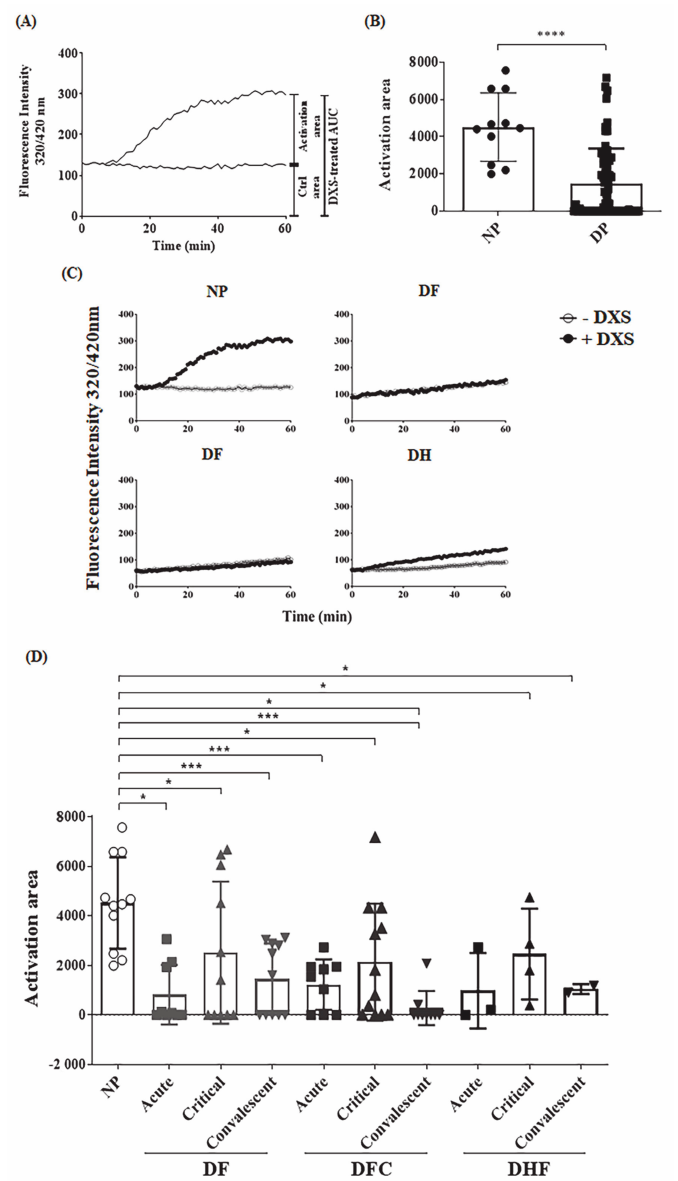
Figure 6. Plasmas from DENV-positive patients present lower PKa activation when challenged with DXS . Plasmas obtained from dengue patients (DP) or control donors (NP) were incubated with intramolecularly quenched peptide substrate (PKaS), in the presence or not of dextran sulfate (DXS). Activation of KKS was evaluated by measuring fluorescence emission due to substrate hydrolysis for 1 h. ( A ) Representative curve obtained after spectrofluorimetric analysis (O.D.) with normal human plasmas (NP) incubated or not with DXS. The subtraction of the control area (ctrl) from the total area represent the activation area, which will be used in the bar graphs. ( B ) Activation area graphs obtained after analysis of the hydrolysis assays. Bars represent mean ± SD, and the dots indicate the individual data obtained from all NP in comparison to all plasmas from dengue patients (DP). ( C ) Representative hydrolysis curves obtained with one NP and DP from patients clinically classified as dengue fever (DF), complicated dengue fever (DFC) or dengue hemorrhagic fever (DHF) treated or not with DXS. ( D ) Plasmas samples were collected at acute (2–3 days), critical (5–7 days) and convalescent phases (<30 days) of infection from the same patients. The plasmas were incubated with PKaS, in the presence or absence of DXS. PKa activity was evaluated in each sample by measuring the substrate hydrolysis and the activation area was measured based on the hydrolysis plot. * represents p ≤ 0.05; *** p ≤ 0.001; **** p ≤ 0.0001. Having established the area under the curves as a criteria for measuring PKa activity in plasma activated or not by DXS, we then screened samples from different clinical